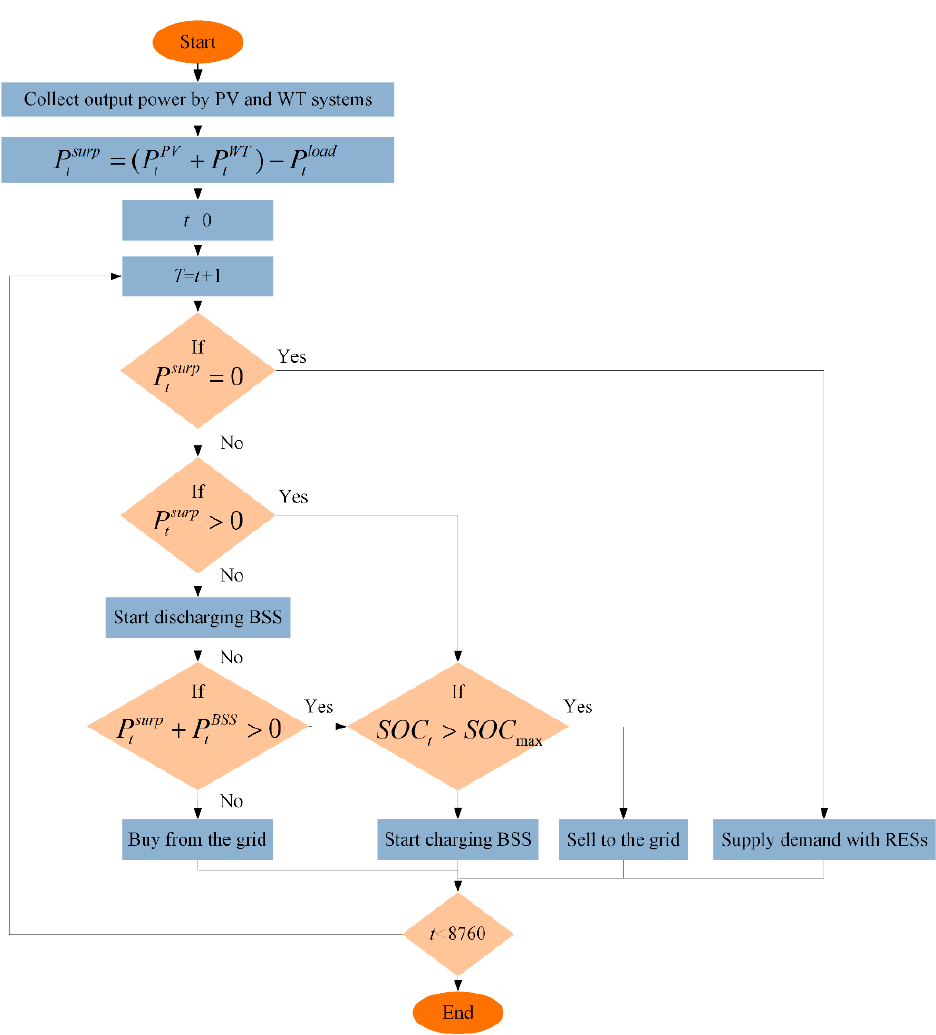
Figure 3. Flowchart of the energy management system.